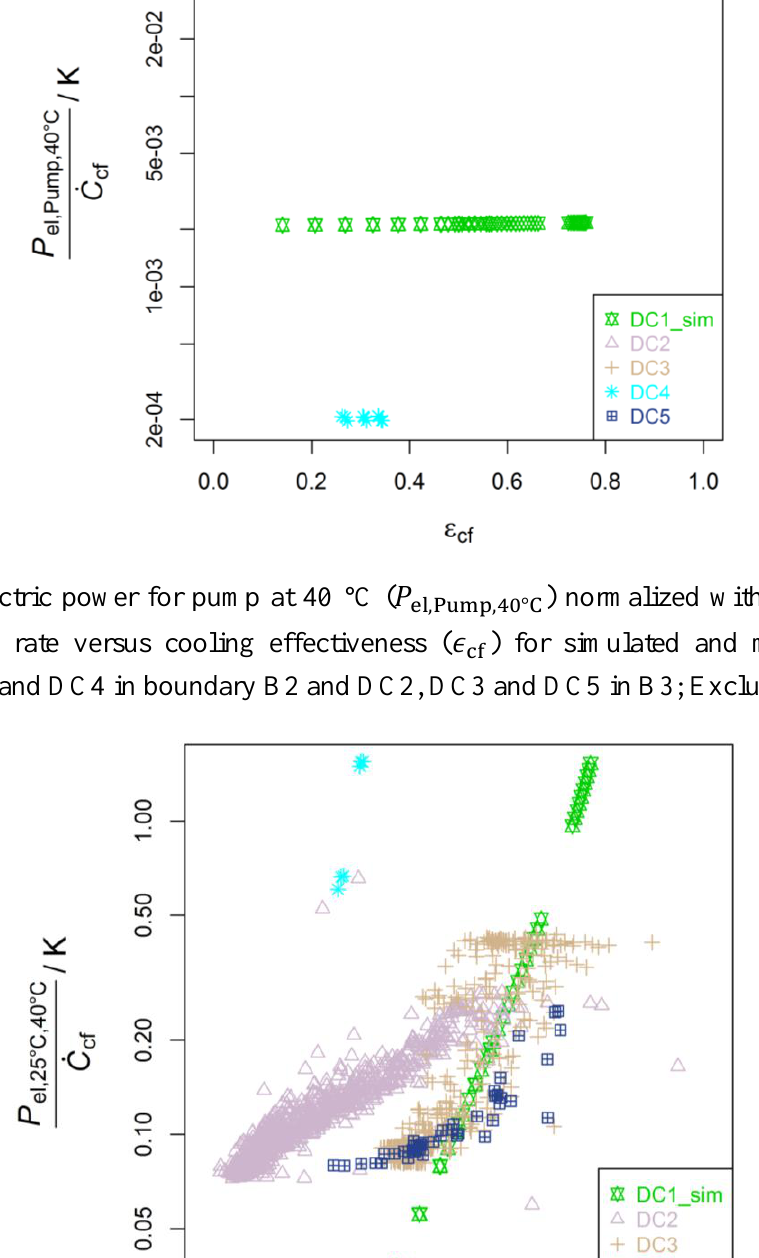
Figure 8. Electric power for fans and pump at 25 °C and 40 °C ( 𝑃 with cooling fluid capacity flow rate versus cooling effectiveness ( ϵ monitored dry coolers (DC1 and DC4 in boundary B2 and DC2, DC3 and DC5 in